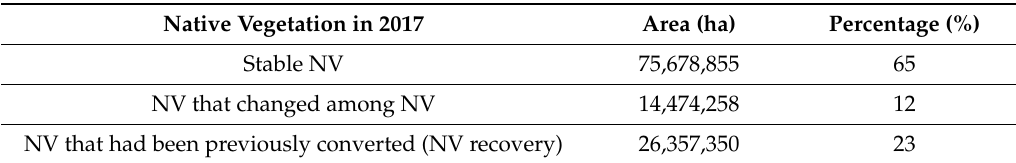
NV that had been previously converted (NV